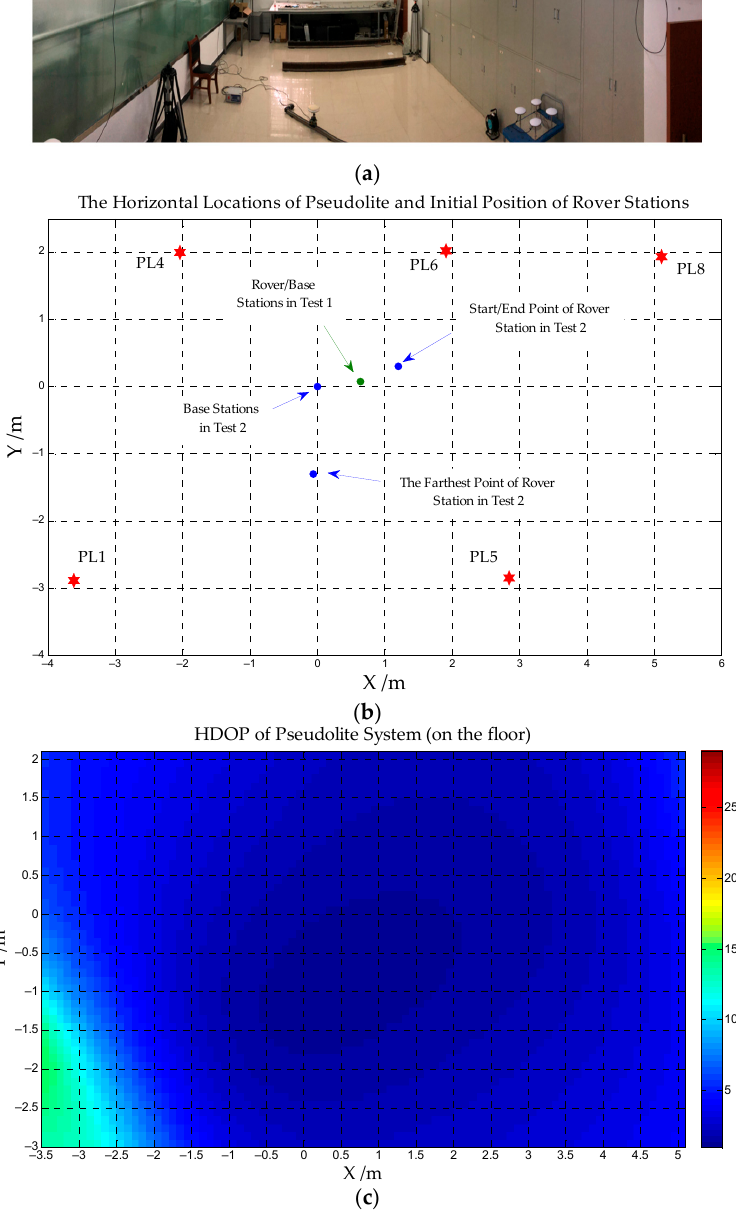
Figure 4. ( a ) Pseudolite Constellation in the Laboratory, ( b ) The Horizontal Locations of Pseudolite and Initial Position of Rover Stations, ( c ) HDOP of Pseudolite System(On the Floor).